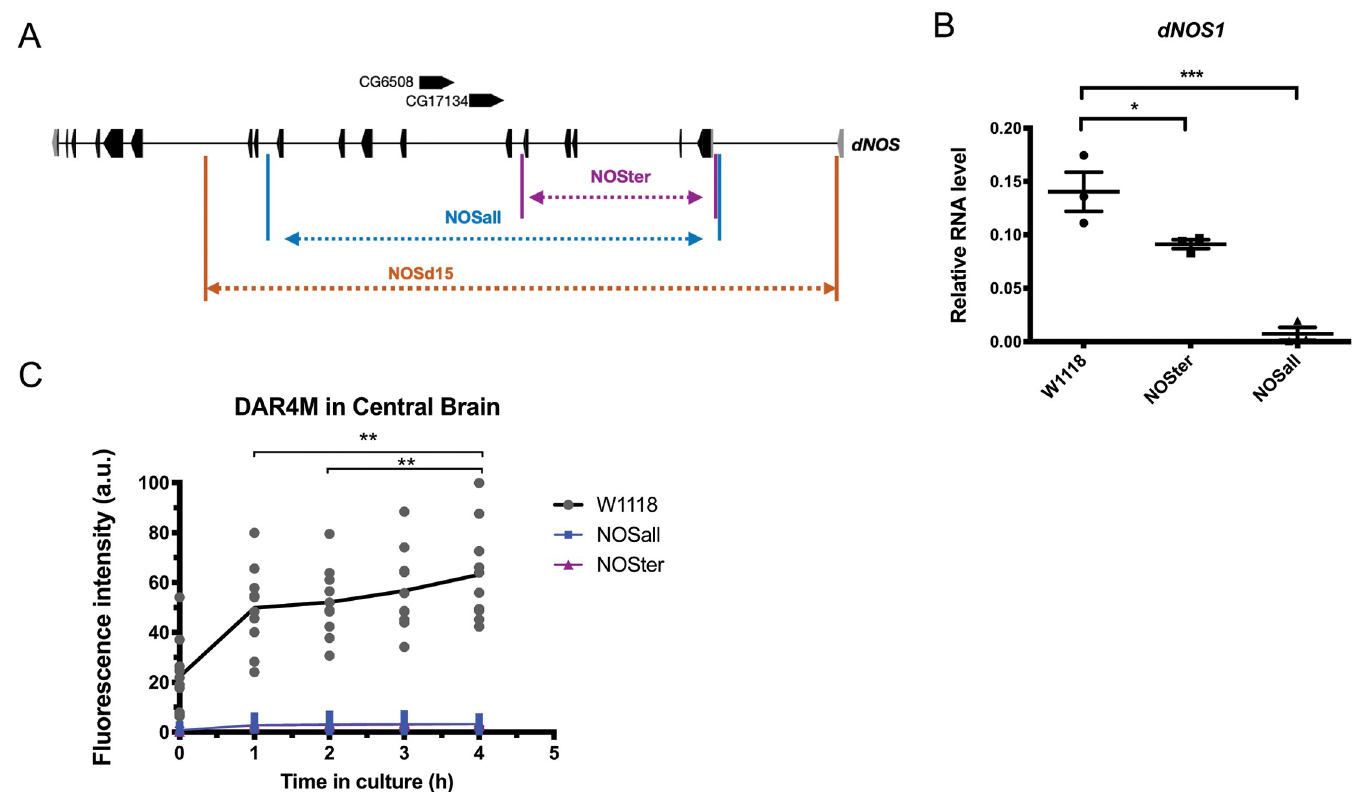
Fig 1. NOS Δ mutants do not produce nitric oxide. (A) NOS gene, and regions deleted in NOS Δ all, NOS Δ ter and NOS Δ 15 mutants. Two genes reside within the NOS locus. (B) mRNA levels of NOSd1 , a full-length functional isoform of NOS , at ZT2 in the heads of NOS Δ all and Δ ter mutants and w 1118 were analyzed using qPCR. Mean values of three independent experiments ± SD are shown. NOSd1 expression levels were significantly reduced in the mutants compared with w 1118 . � p < 0.05, ��� p < 0.001 (One-way ANOVA with Dunnett’s multiple comparisons test). (C) NO levels were measured using DAR4-M dye in the brain explants of NOS Δ all and Δ ter mutants and w 1118 for 4 h using timelapse microscopy. Each dot represents the DAR4-M fluorescence intensity of a single brain explant and the line indicate the mean in arbitrary unit (a.u.). n = 5–11 brains per group. Different time points within the group were compared using two-way ANOVA with Tukey’s multiple comparisons test ( �� p < 0.01).